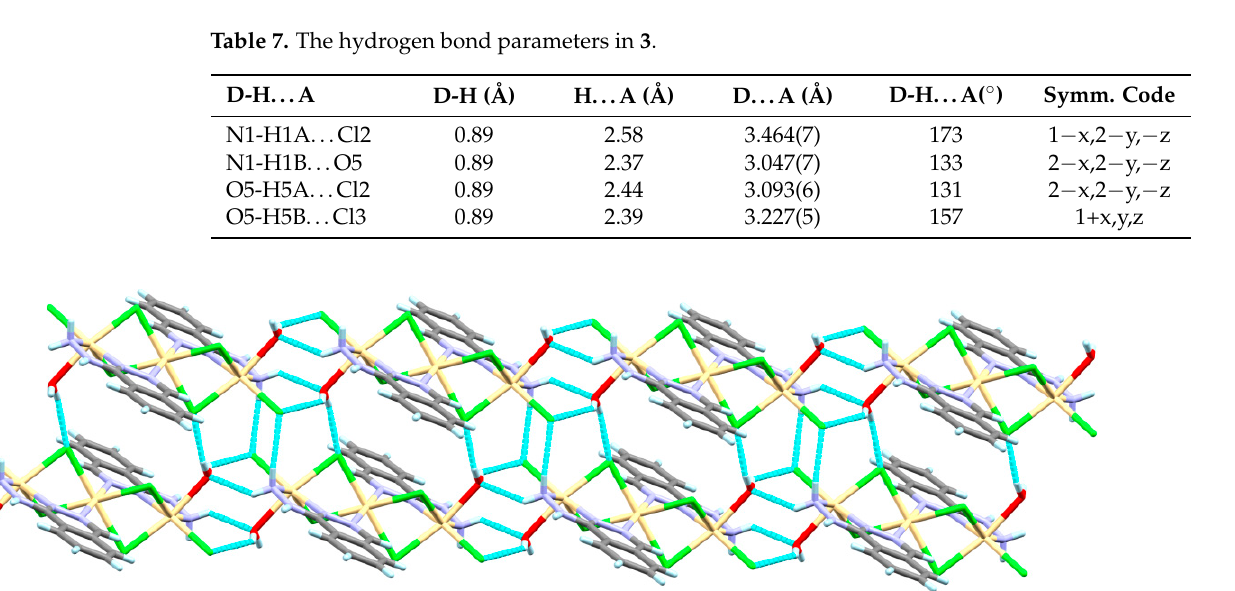
Figure 10. The 2D hydrogen bonding network of 3.